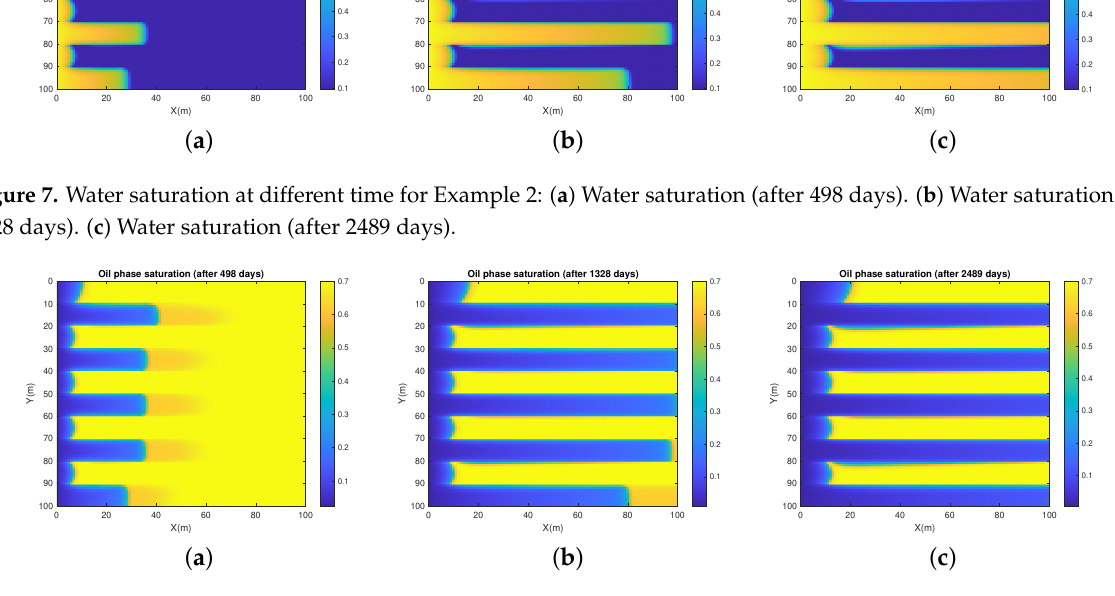
Figure 8. Oil saturation at different time for Example 2: ( a ) Oil saturation (after 166 days). ( b ) Oil saturation (after 2489 days). ( c ) Oil saturation (after 8296